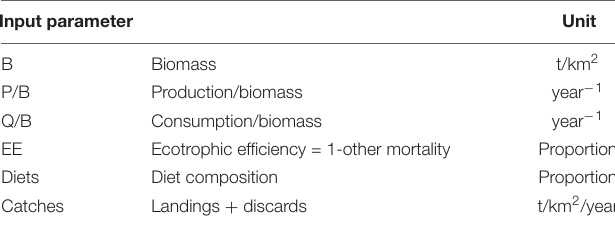
TABLE 1 | Data requirements for Ecopath